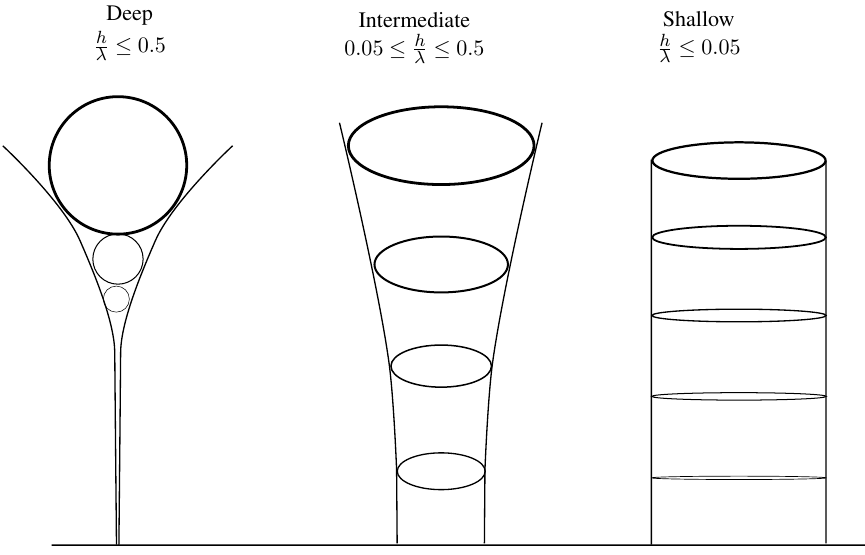
Figure 1. Schematic representation of water particle velocities where h is the water depth and λ is the wavelength for different water depths